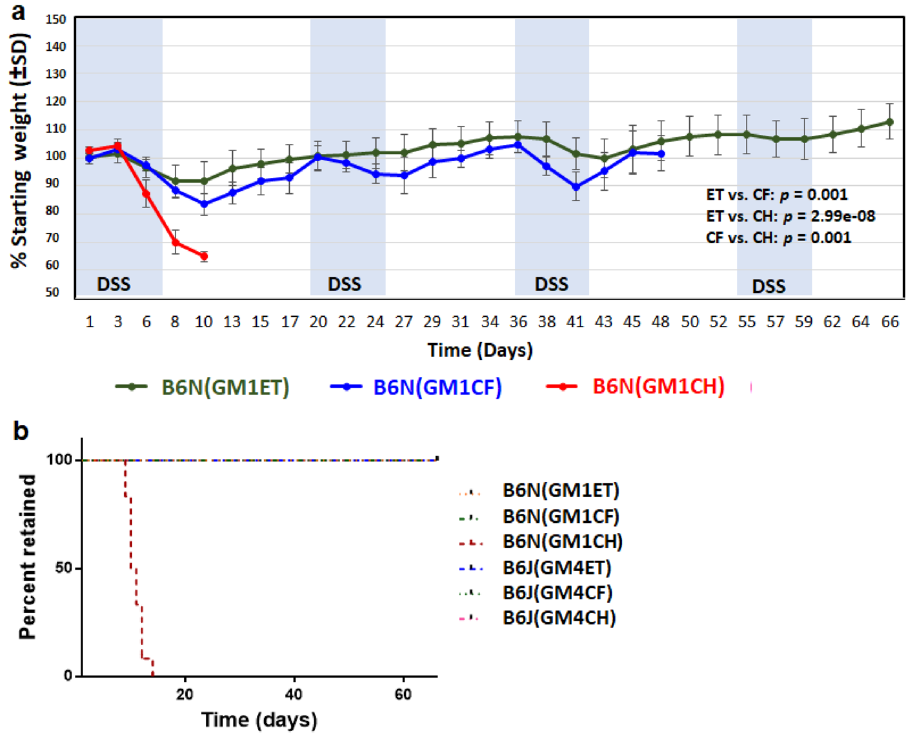
Figure 7. Influence of transfer method on susceptibility to DSS-induced colitis when transferring low-richness GM1 to B6N mice. ( a ) Comparison of DSS-induced weight change between recipient B6N that were recipient of GM1 using ET, CF, and CH transfer method. Statistical analysis revealed the significant difference between transfer methods (ET vs. CH: p = 2.99e-08; ET vs. CF: p = 0.001; CF vs. CH: p = 0.001). There were significant main effects of time ( p = 6.66e-21), sex ( p = 0.013), DSS treatment ( p = 9.07e-43), and a time / DSS treatment interaction ( p = 2.79e-27). The longitudinal measurements of each mouse were considered. Random intercept mixed effect model with AR covariance structure was performed for statistical analysis. Two-factor (time and transfer method) ANOVA. The figure shows data from both sexes. ( b ) Survival curve of B6J and B6N mice groups generated using the different transfer methods ET, CF, and CH. (Kaplan Meier survival analysis in GraphPad Prism). Analysis using a Log-rank (Mantel-Cox) test demonstrated statistical significance of this observation ( p < 0.0001). From days 49–66, weights were inadvertently not recorded for the B6N (GM1CF)